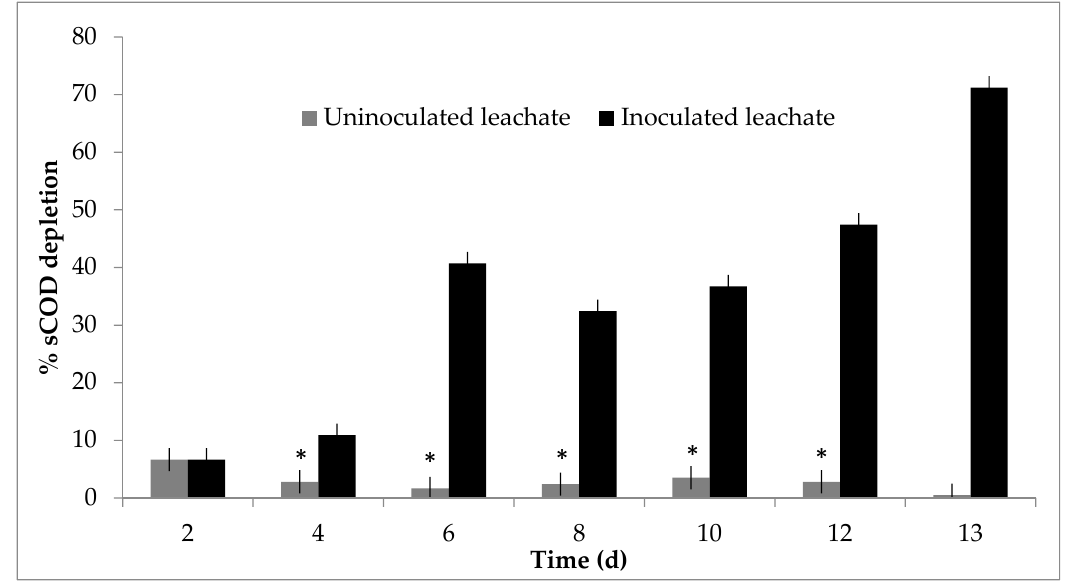
Figure 1. Percentage of sCOD depletion in Summit Road old LFL by using the Lambertella sp. as suspended biomass in presence of 0.1% ( v / v ) Malt Extract Broth (MEB). Values represent mean values of the percentage of sCOD depletion from three replicates with reference to the initial concentration. Bars represent the standard deviation (SD) among the three replicates of analysis. All the values are significantly different from the corresponding value at the previous time of analysis at the 1% level (p < 0.01) with the exception of the bars with asterisk (*).